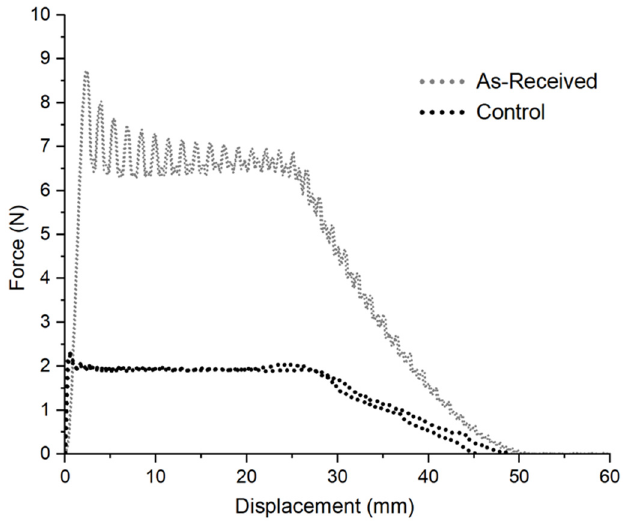
Figure 7. Yarn pull-out force–displacement response of Control and As-received S706 fabrics at 200 N transverse pre-tension.